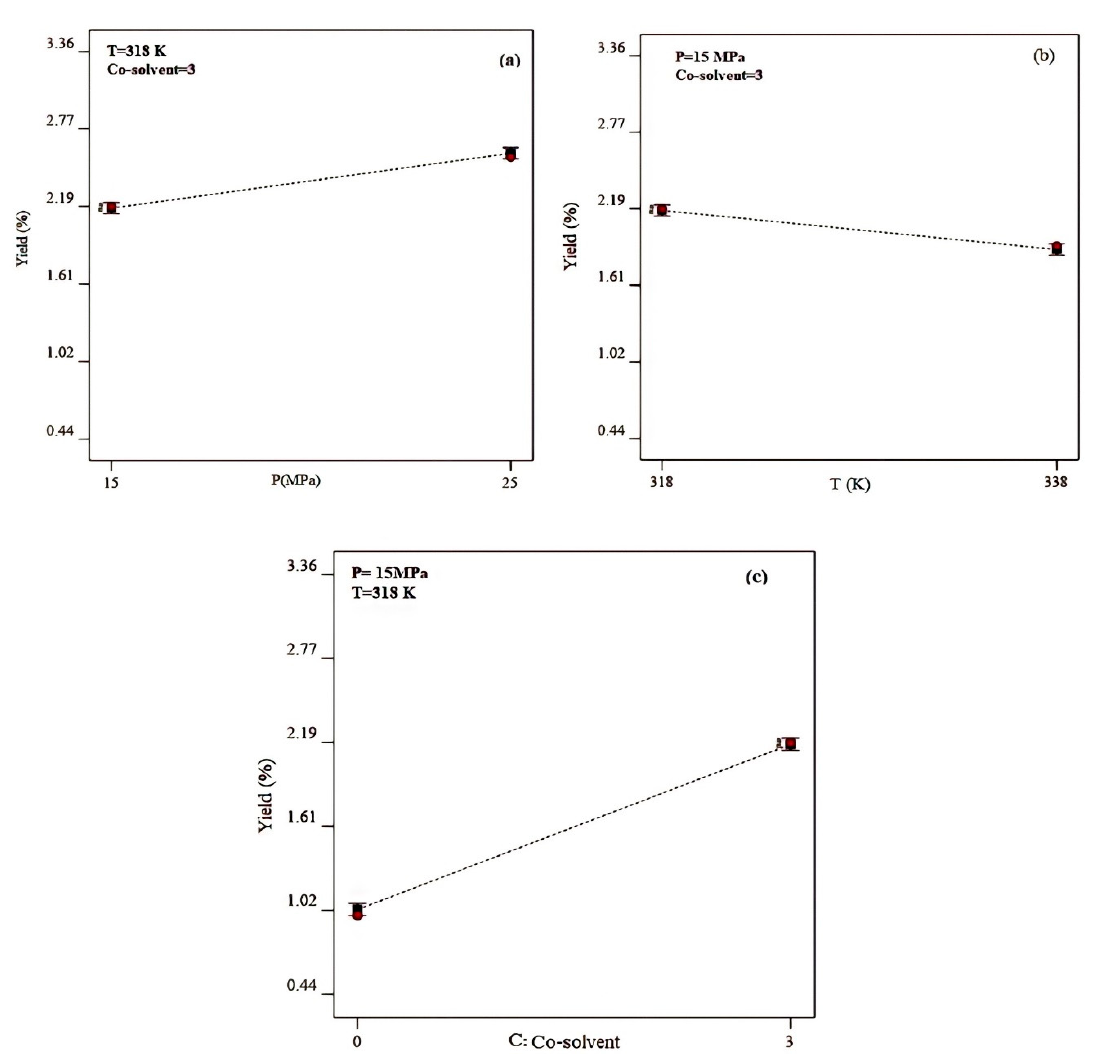
Figure 3. One factor plot to represent the effect of ( a ) pressure at a constant co-solvent concentration of 3% and temperature of 318 K ( b ) temperature at a constant pressure of 15 MPa and a co-solvent concentration of 3%, and ( c ) concentration of co-solvent at a constant temperature of 318 K and pressure of 15 MPa, on the yield of extraction. Table 1. Analysis of variance (ANOVA) for the model fitted to the SC-CO 2 extraction